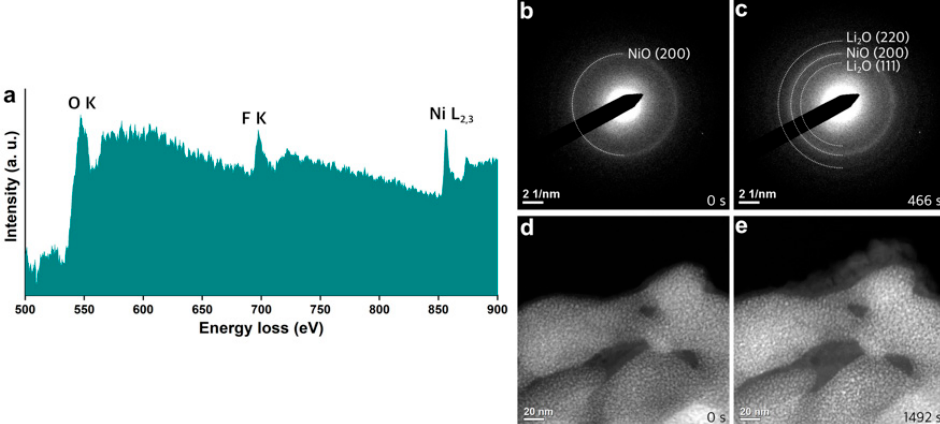
Figure 3. ( a ) EELS acquired from a part of pre-cycled NiO. SAED patterns and HAADF-STEM images obtained ( b , d ) before and ( c , e ) after in situ lithiation. In situ experiments were performed separately for the acquisition of SAED and HAADF-STEM.